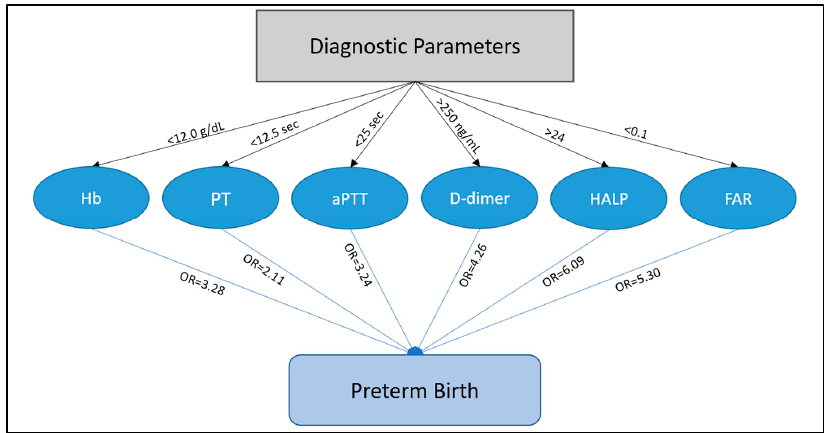
Figure 4. Flowchart of factors associated with preterm birth.